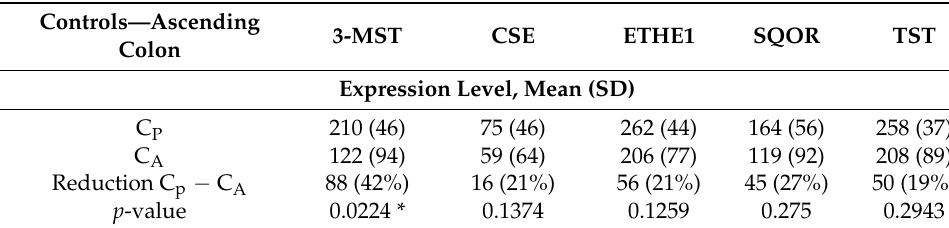
Table 4. Expression as mean with standard deviation (SD), absolute reduction and percentage as well as p -value of the ascending colon of the healthy control group (C) separated by age group. Pediatric (P); adult (A). cystathionine- γ -lyase (CSE), 3-mercapto-sulfurtransferase (3-MST), ethyl- malonic encephalopathy 1 protein (ETHE1), sulfide:quinone oxidoreductase (SQOR) and thiosulfate sulfurtransferase (TST). * = p -value < 0.05.